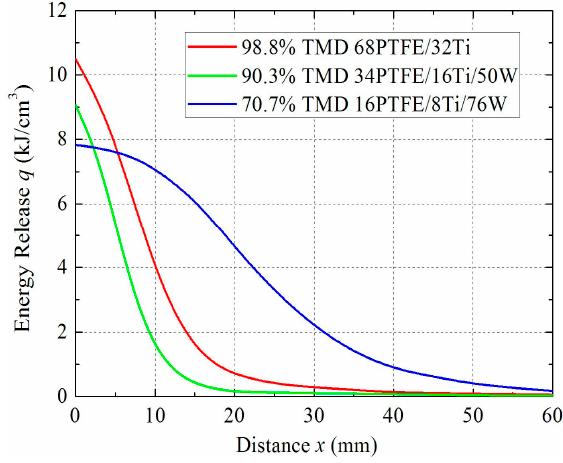
Figure 15. Curves of energy release changing with distance.